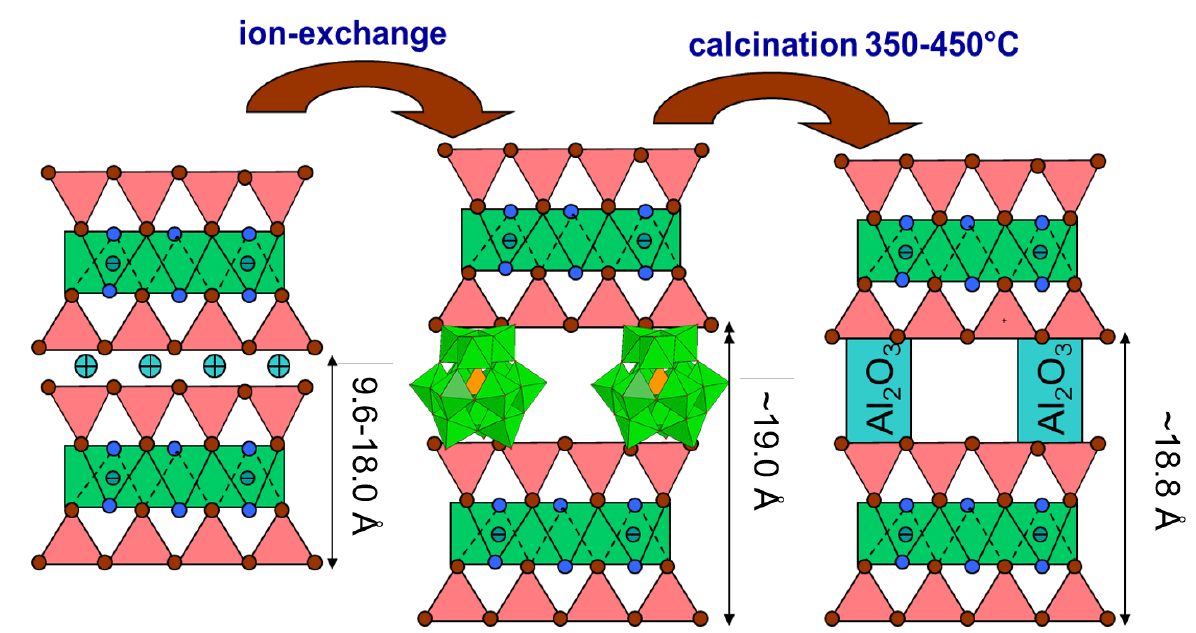
Figure 2. Intercalation of cationic layered clay minerals with alumina pillars. Aluminum Kegging polyoxocations, [Al 12 (AlO 4 )(OH) 24 (H 2 O) 12 ] 7+ , were used as precursors of Al 2 O 3 pillars. Reprinted with permission from ref. [2]. Copyright 2018 Elsevier.